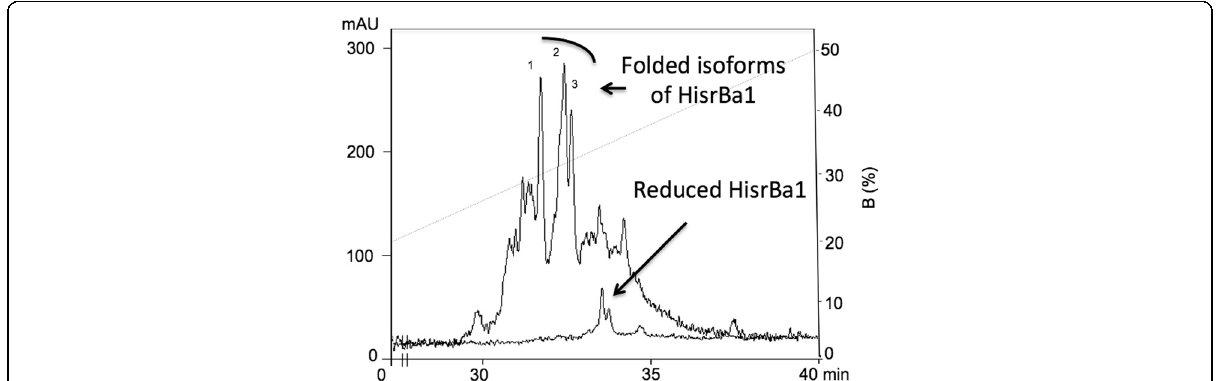
Fig. 4 rpHPLC separation of the in vitro folding of HisrBa1. The components of the in vitro folding reaction of HisrBa1 were separated employing rpHPLC (C18 column) using a gradient from 0 to 50 % B in 50 min at 1 mL/min. A superimposed chromatographic rpHPLC profile under the